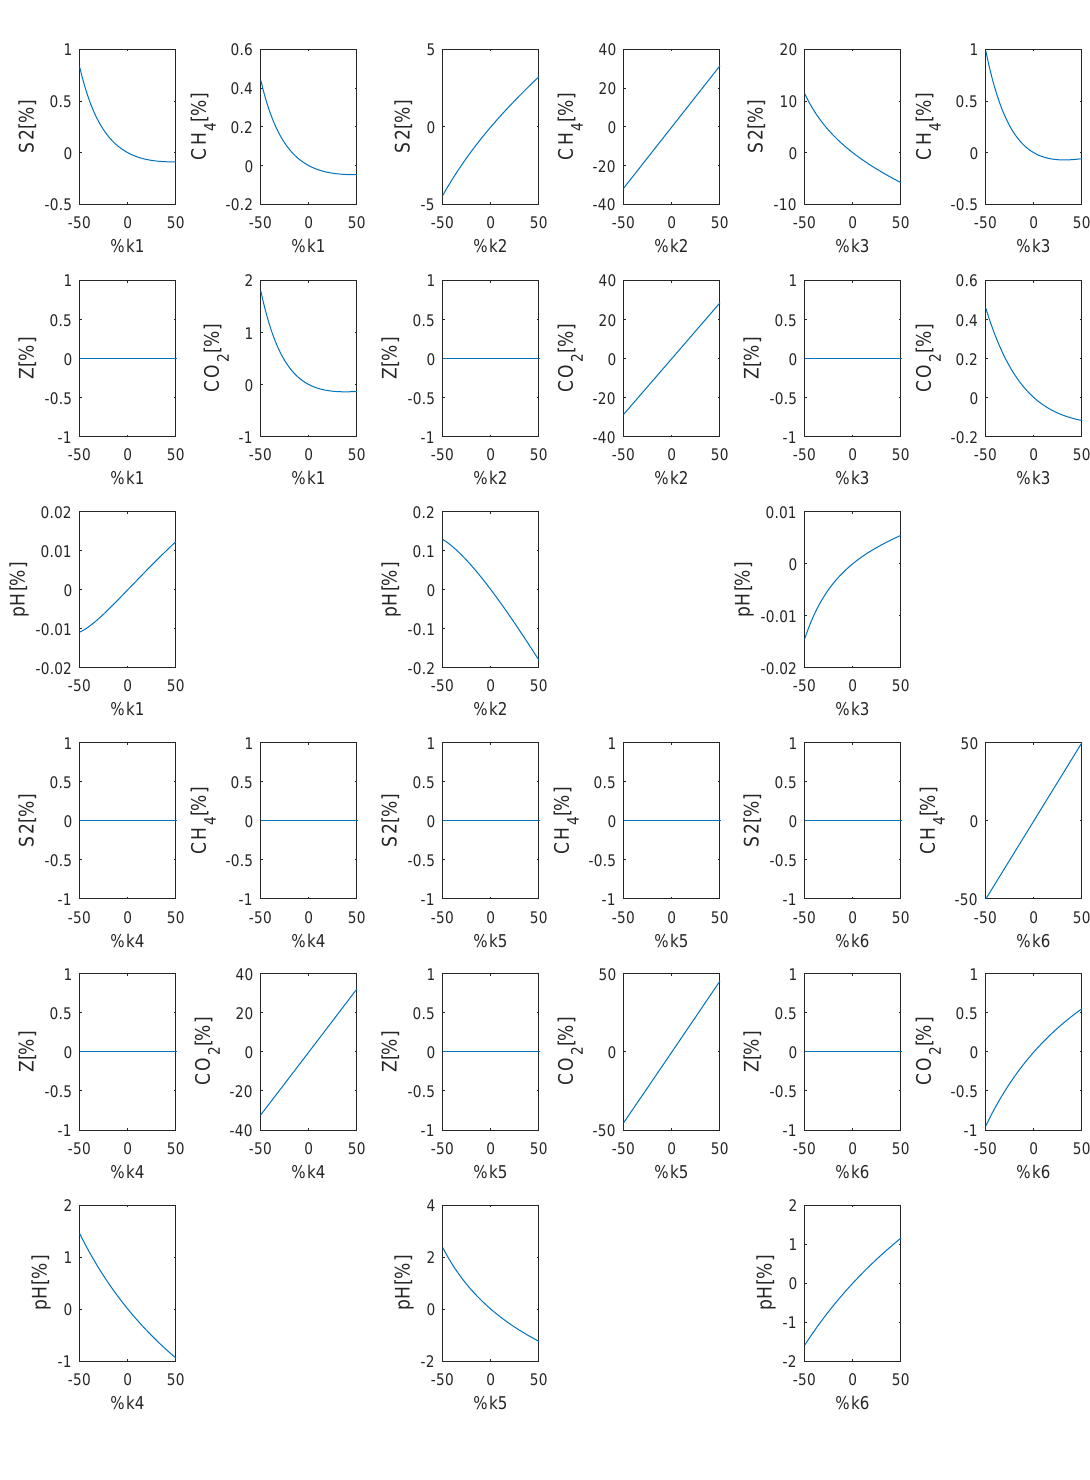
Figure 5: The sensitivity for the yield coefficient model